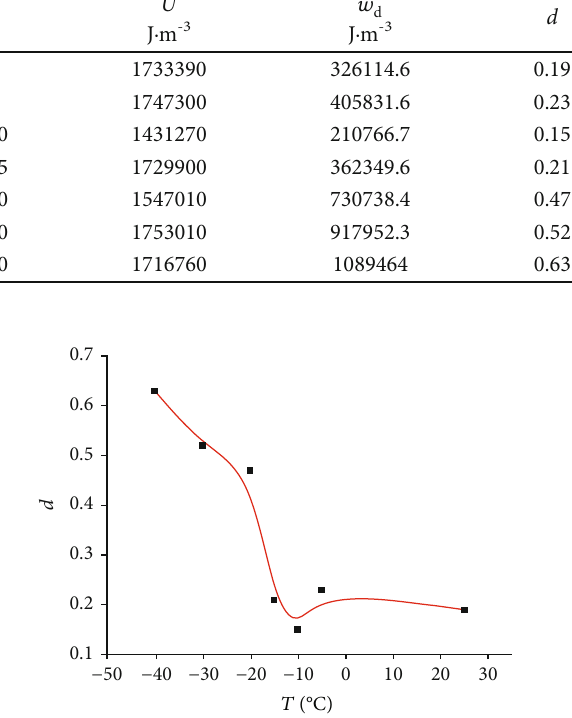
Figure 10: Damage variable vs. temperature under dynamic impact.